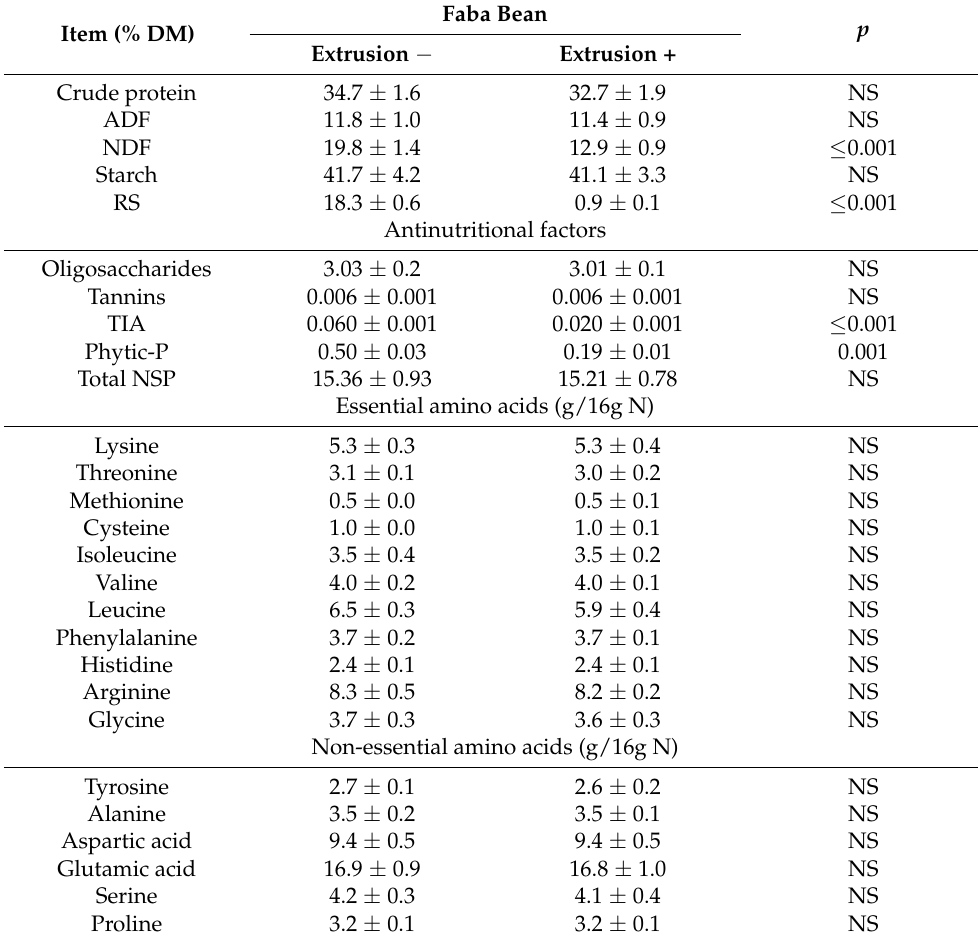
Table 1. The chemical composition, anti-nutritional factors, and amino acid profile of raw and extruded faba bean seeds ( n = 4). Item (%